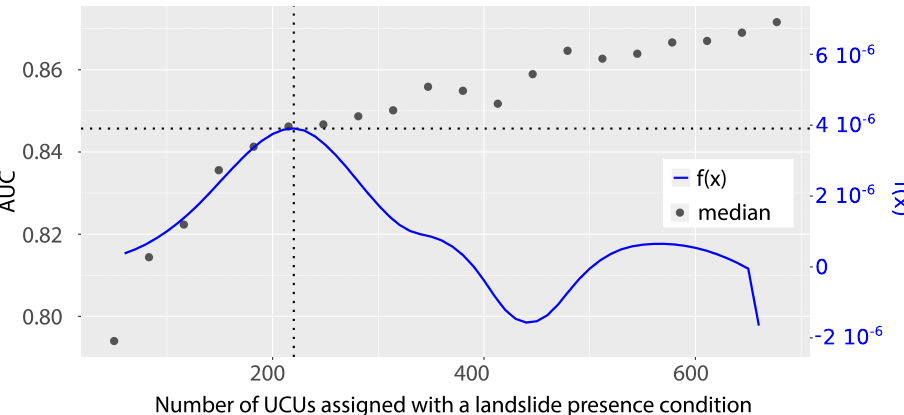
Figure 11. Graph in dots of the median AUC also visible in Figure 8 and the relative f function (Equation (2)) which measure how much the trend of the median graph